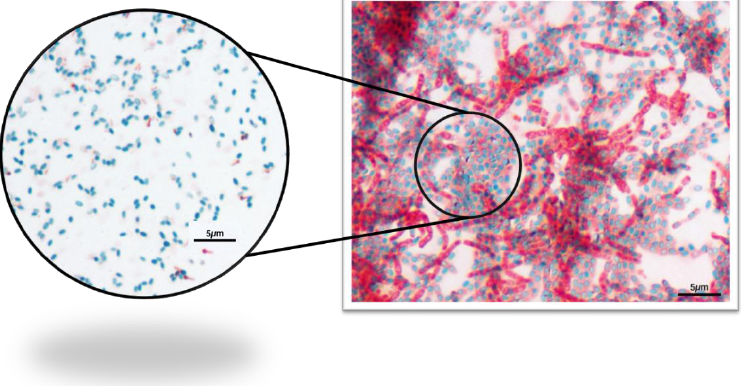
Figure 6. Photomicrographs of the pollen Schaeffer–Fulton endospore stain—1000× total